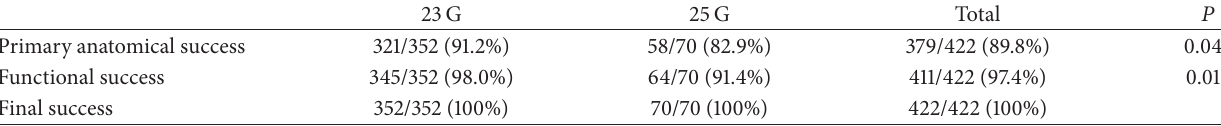
Table 5: Comparison between 23 and 25 G along the whole study period.